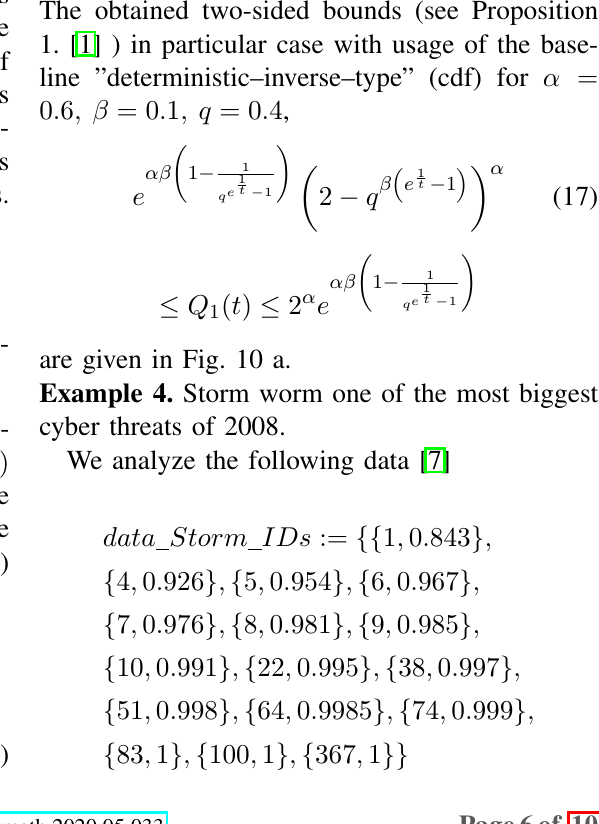
The obtained two-sided bounds (see